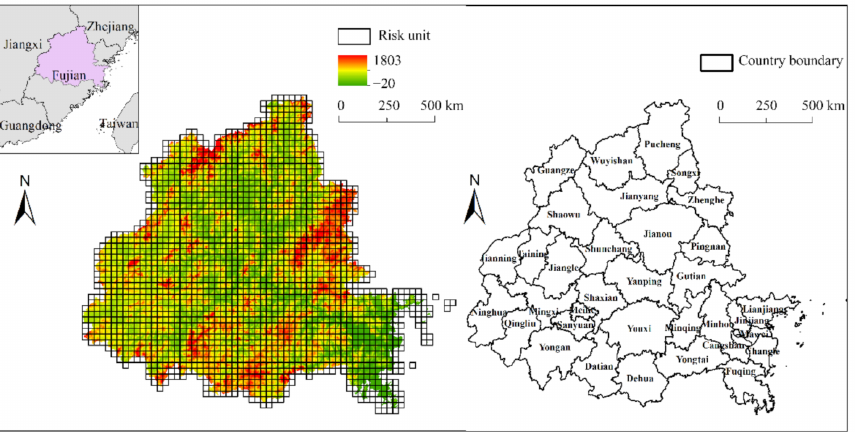
Figure 1. Geographical location, risk unit division, and county boundary in the Min River